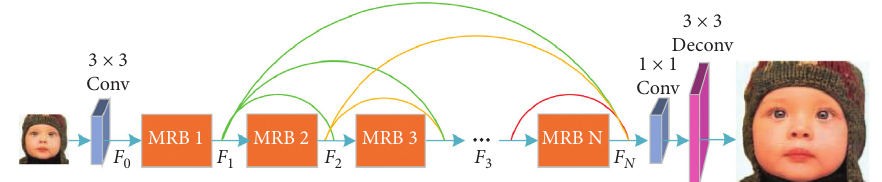
Figure 1: General structure of super-resolution reconstruction network.